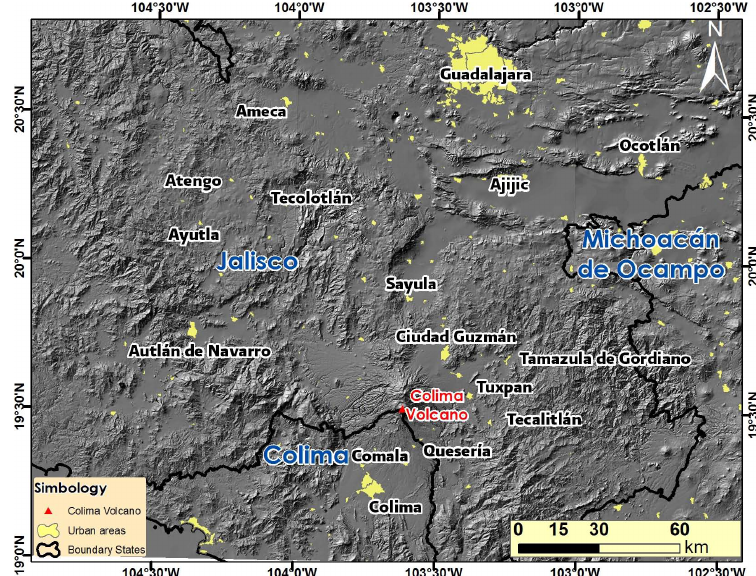
Fig. 2. Map of Colima volcano and surrounding area. Colima City and Ciudad Guzm´an are the largest urban settlements, which along other smaller cities (shown as non-labeled yellow spots) may be seriously affected by ashfall. Guadalajara City (4000000), about 160km North of Colima volcano may also be affected by lighter